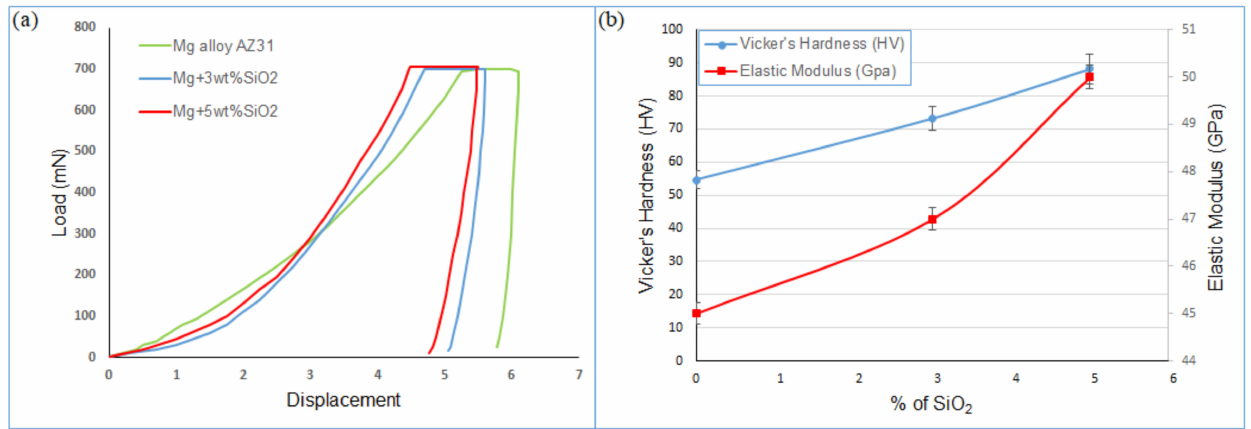
Figure 6. ( a ) Load–displacement curve, ( b ) microhardness and elastic modulus of composites with different wt% of SiO 2